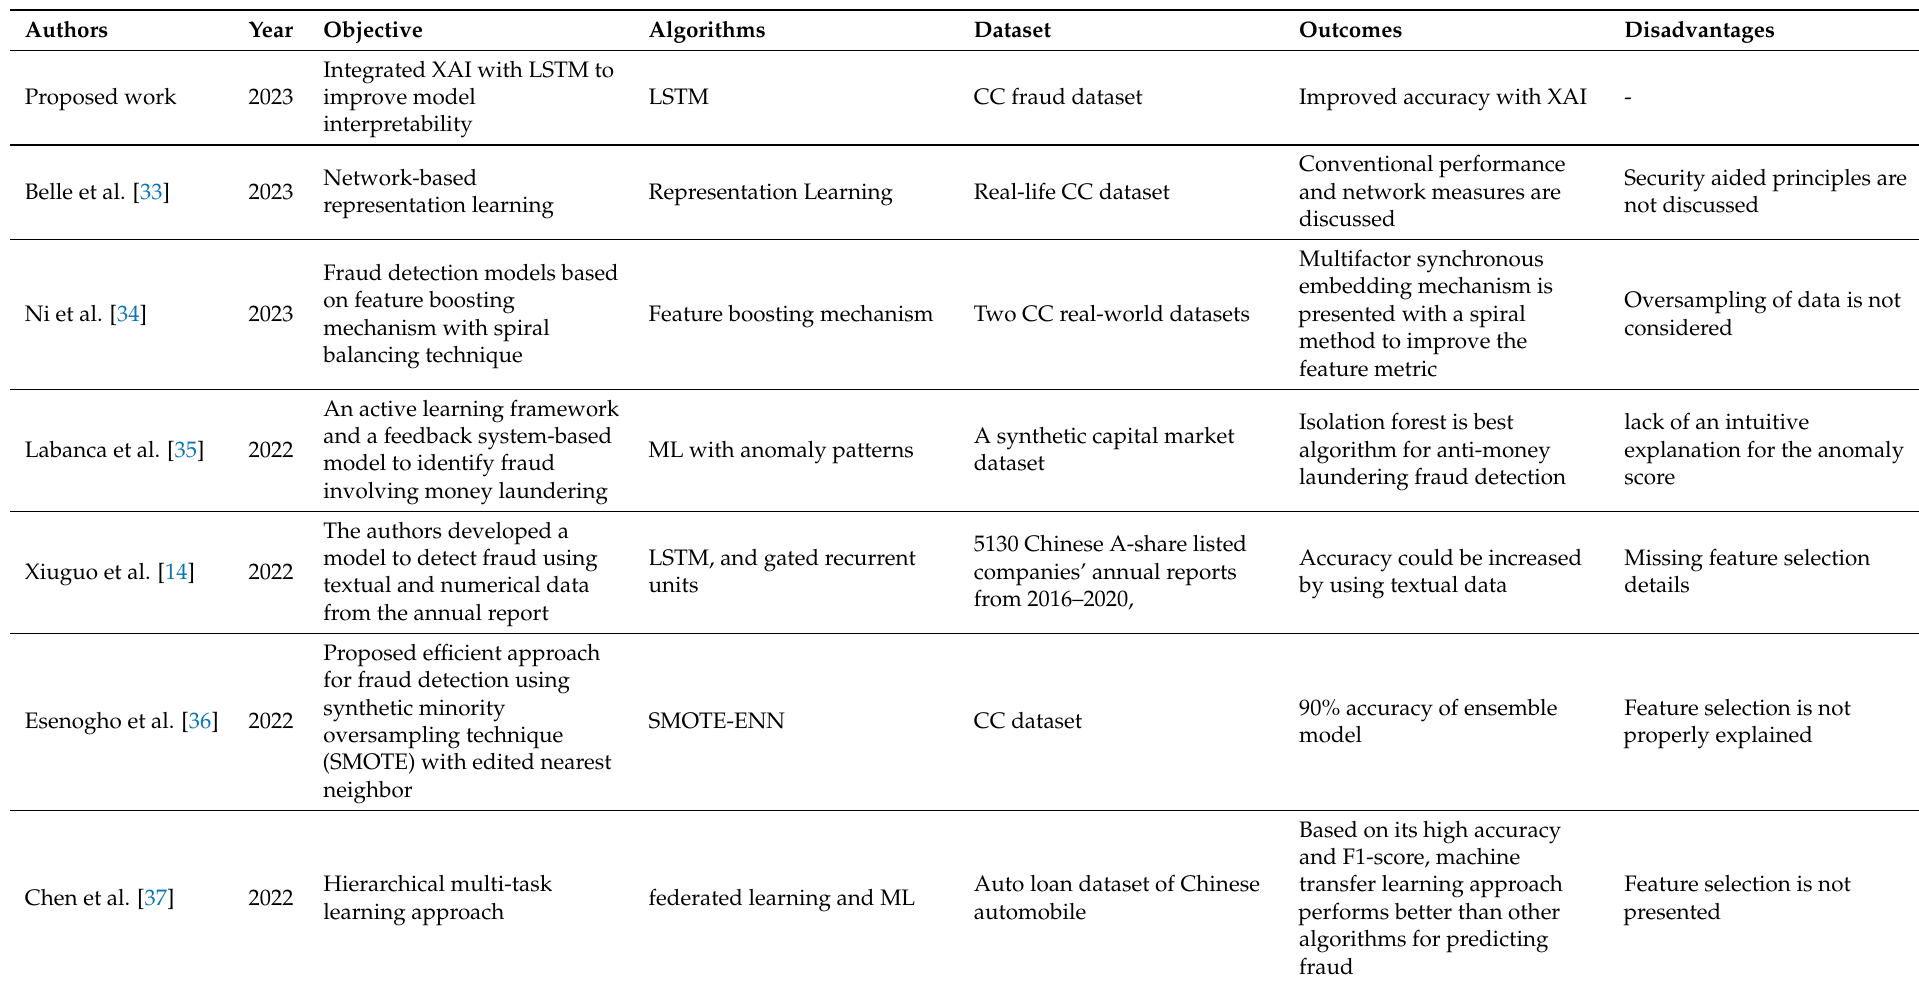
Table 1. Comparative analysis of proposed scheme with SOTA